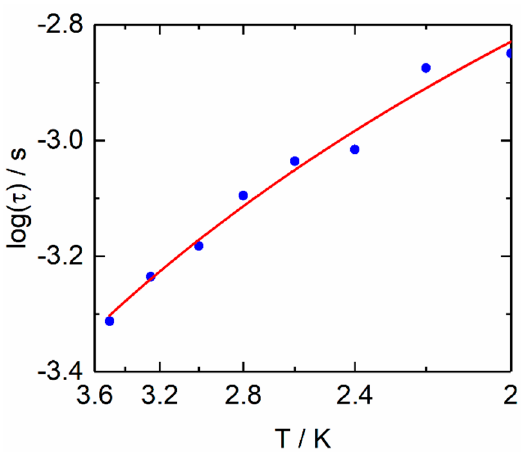
Figure 4. Temperature variation of the relaxation time for 1 in the temperature range of 2–3.5 K (blue spots) with the best fitted curve with a Raman process with C = 175(19) s − 1 K − n and n = 1.95(11) (red line).